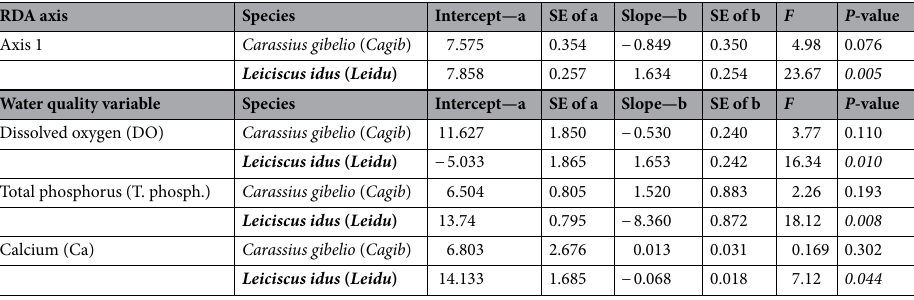
Table 5. GLM analysis of relations between RDA Axis 1 and the biomass of Carassius gibelio —Prussian carp and Leuciscus idus— ide and between water quality variables and the biomass of Carassius gibelio or Leuciscus idus. Symbols of variables that were used in the RDA figure are in brackets. The species whose biomass significantly correlated with a given water quality variable are in bold font, and significant P -values are in italic